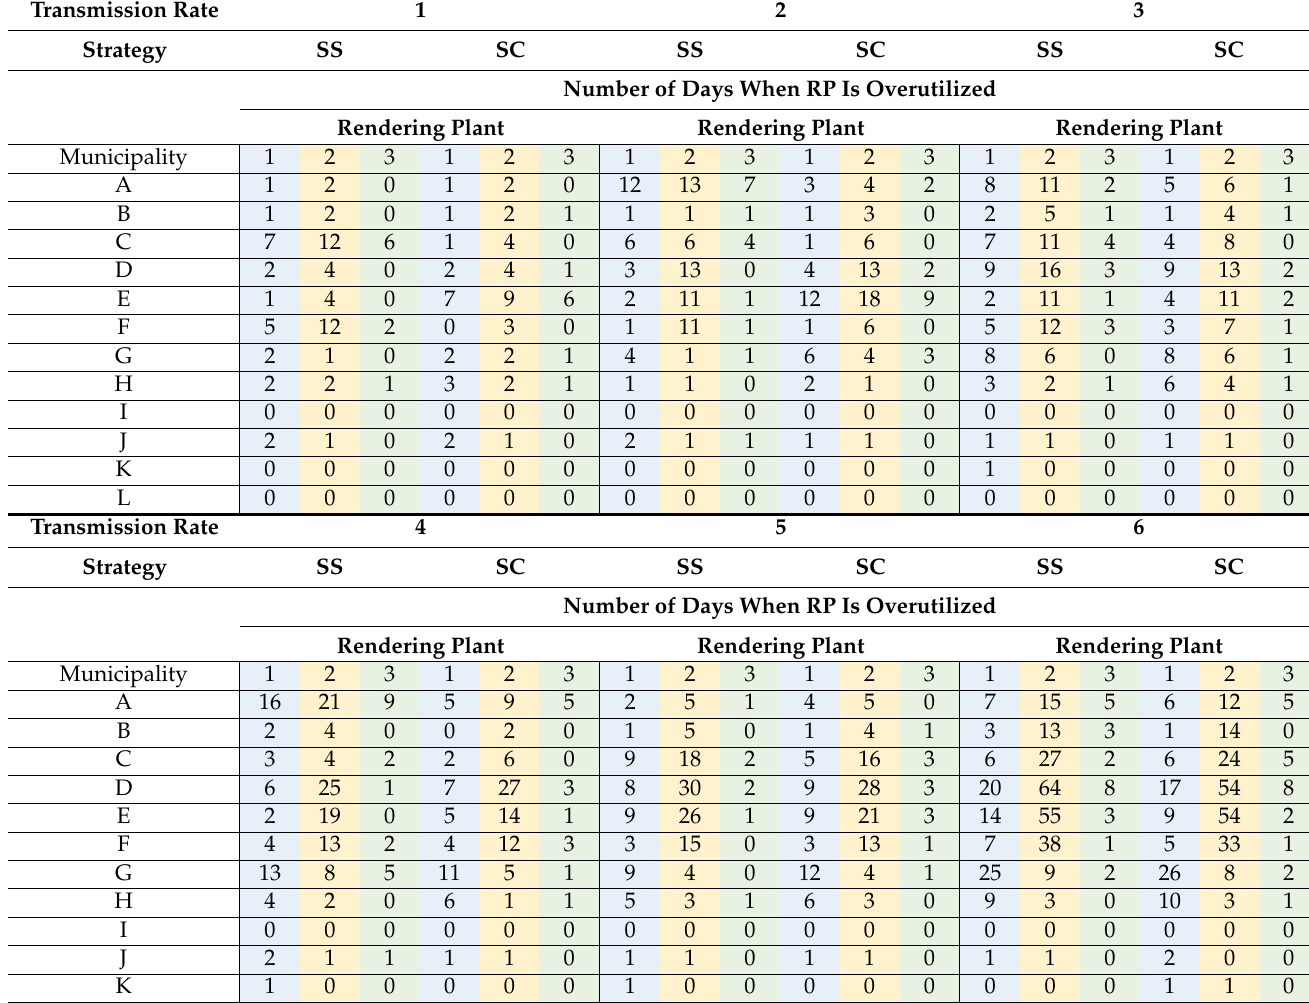
Table 5. Number of days with exhausted capacity in rendering